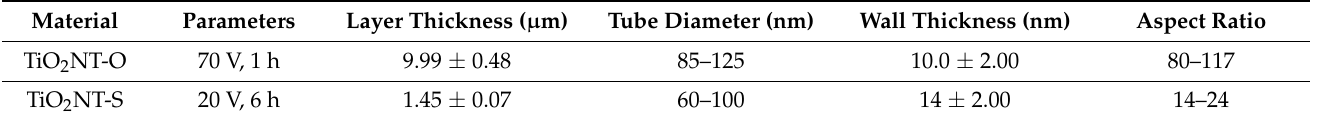
Figure 3. Surface morphology of the unaged samples. Table 3. Nanotube